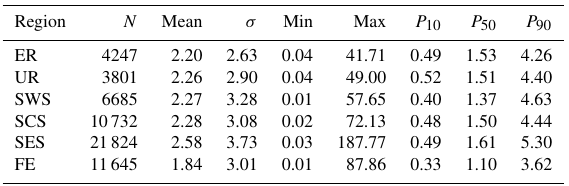
Table 4. The bulk contribution of motor vehicle exhausts, χ (%), to the near-surface abundance of T and B along the Trans-Siberian Railway (see Eq.